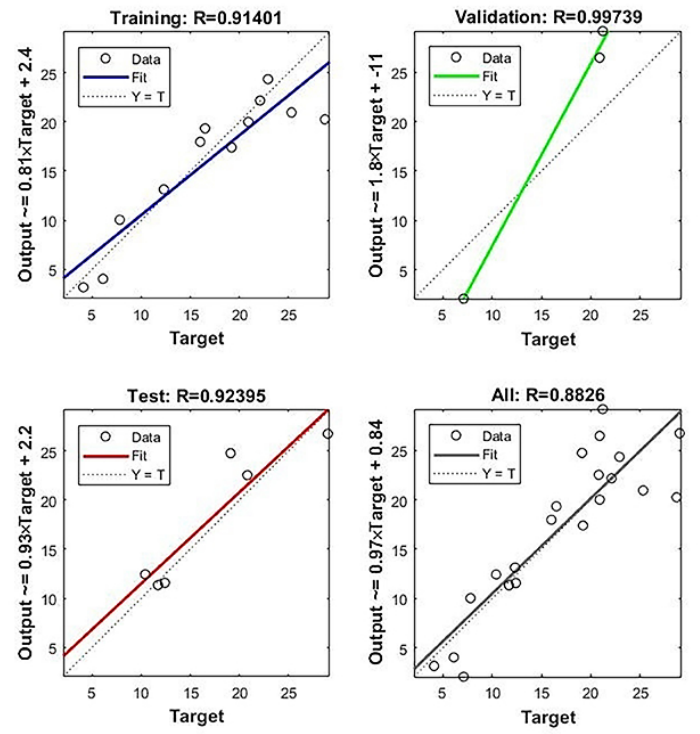
Figure 18. PSO-BP plot regression. Further subdivision of hole bottom distance and minimum resistance line to predict blast block rate based on production accuracy requirements. Input the design samples for predicting the fragmentation of deep-hole blasting, and output the PSO-BP network prediction results of the fragmentation of deep-hole blasting after meeting the requirements of maximum iteration times or errors. Use PSO-BP network to calculate the data in Table 7. When the rock density is 3.14 t·m − 3 , the compressive strength of the rock is 98.4 Mpa, and the Joint crack is 1.76 strip m − 1 , the optimal blasting block rate of 6.83% can be achieved by arranging 75 mm drill holes, setting the bottom distance of the holes at 2.2 m, the minimum resistance line at 1.4 m, and the primary explosive unit consumption is taken as 0.629 kg ·m − 3 . This parameter has been applied to Sanxin Gold and Copper Mine Company. Table 7. Predictive design data.